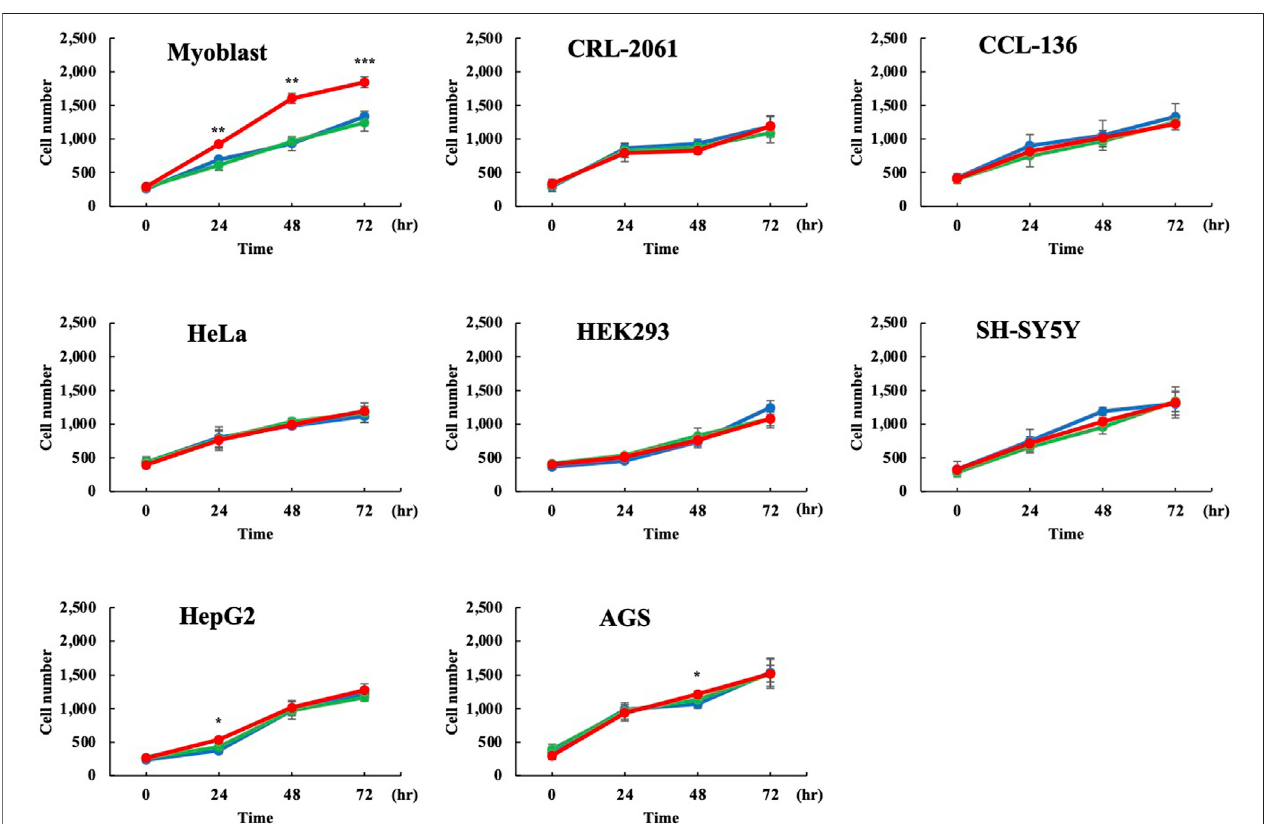
FIGURE 5 | No enhancement of proliferation of human nonmyoblast cells by Dp71ab. Dp71ab, Dp71 and mock vectors were transfected into eight human cell lines,andtheircellnumberswereassessedmicroscopicallyat0,24,48and72 h(red,green,andbluelines,respectively).Dp71didnotincreasethecellnumberinallcell lines examined compared with the control (myoblast, CRL-2061, CCL-126, HeLa, HEK293, SH-SY5Y, HepG2 and AGS). As expected, Dp71ab signi fi cantly increased the number of myoblasts compared with that of the mock plasmid-transfected cells ( p < 0.001). However, Dp71ab had no effect in the other seven cell lines, including two myogenic cell lines (CRL-2061 and CCL-136). * = p < 0.05, ** = p < 0.01, *** = p ≤